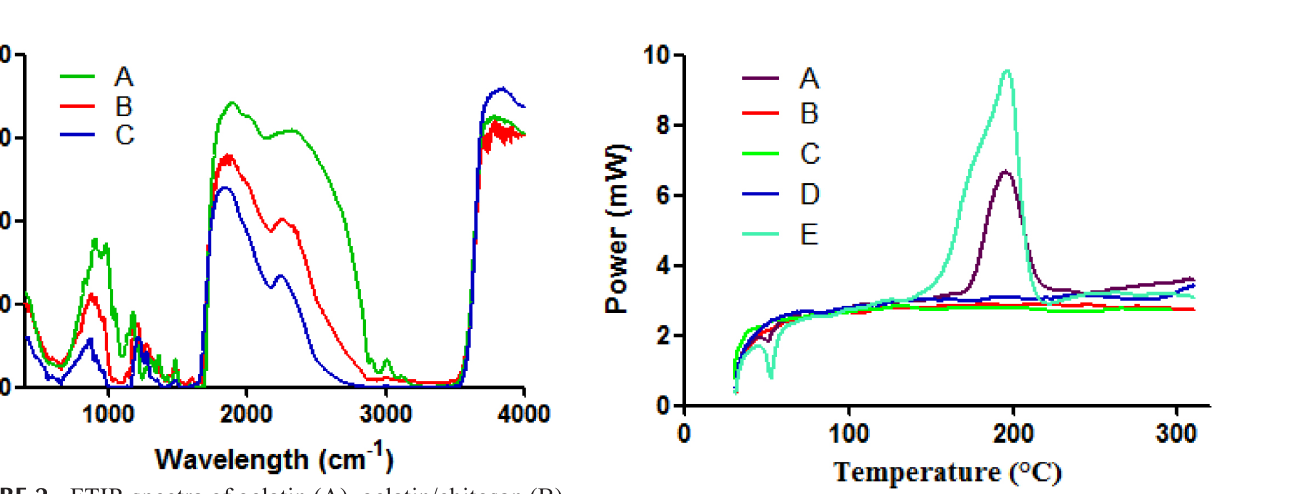
FIGURE 2 - FTIR spectra of gelatin (A), gelatin/chitosan (B) and chitosan (C) films.